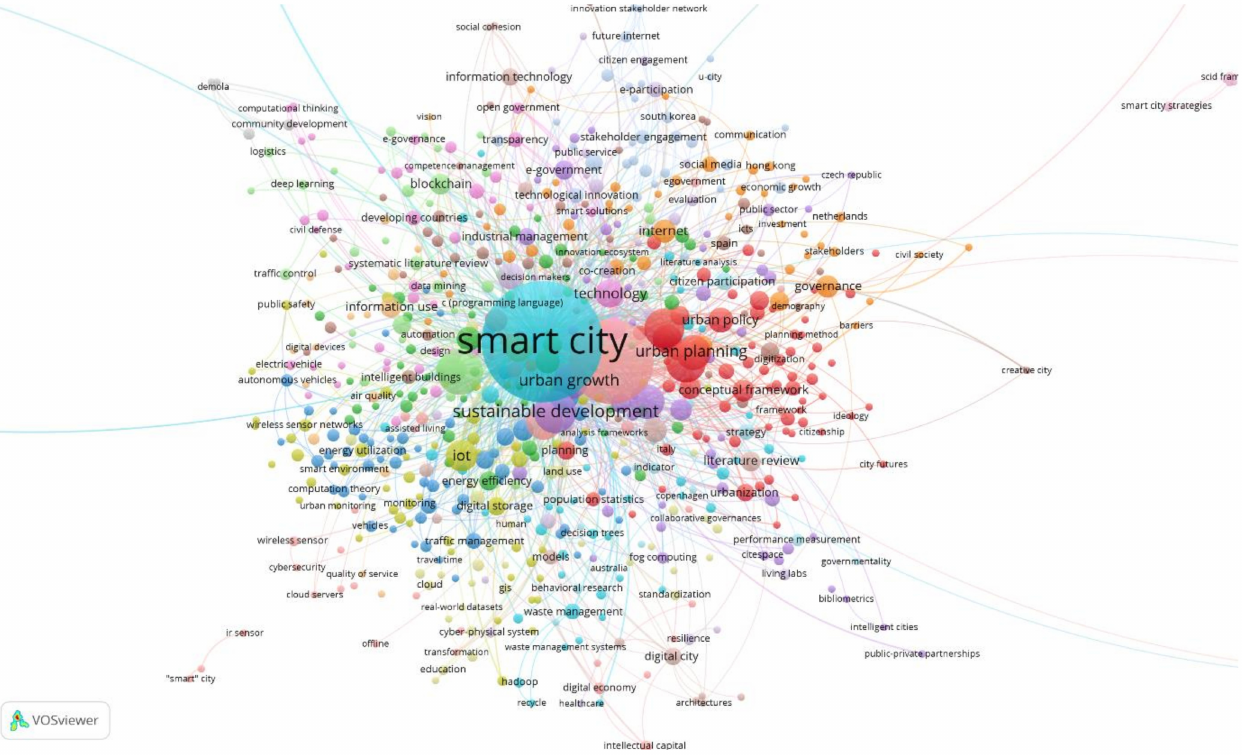
Figure 10. Visualization of a set grouped into